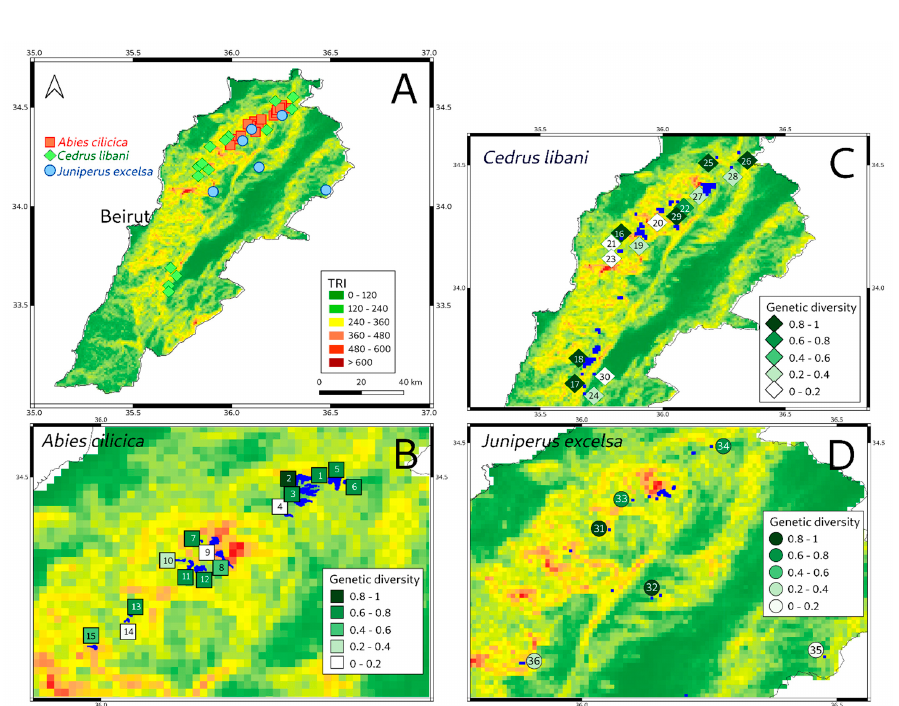
Figure 2. Terrain Ruggedness Index (TRI) of Lebanon showing the location of the studied populations of Abies cilicica , Cedrus libani , and Juniperus excelsa ( A ) and their genetic diversity from Awad [42] ( B ), Fady [45], Bou Dagher-Kharrat [43] and Semaan & Dodd [46] ( C ), and Douaihy [44,58] ( D ). Ref. [42]. For comparison purposes, we scaled the different genetic diversity markers used by the authors between 0.1 and 1.